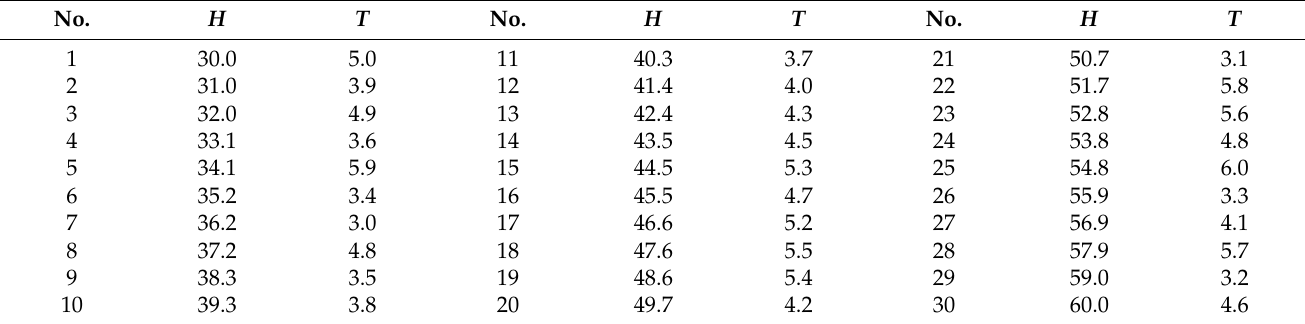
Table 1. Thirty sample points with different H and T values of guiding fins (mm).